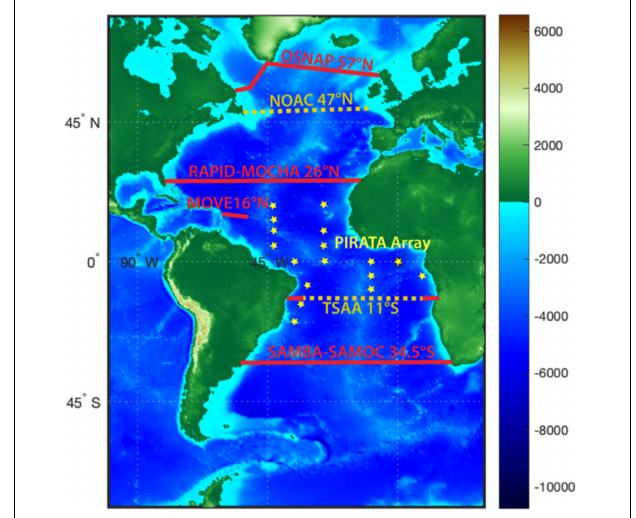
FIGURE 1 | Scheme of the moored observing arrays in the Atlantic with AMOC transports estimates from OSNAP 57 ◦ N, NOAC 47 ◦ N, RAPID 26 ◦ N, MOVE 16 ◦ N, TSAA 11 ◦ S, and SAMBA-SAMOC 34.5 ◦ S (see Frajka-Williams et al., 2019 for more details) and the Tropical Atlantic PIRATA mooring array (see Foltz et al., 2019 for more details). Argo and underwater glider arrays can be found in Roemmich et al. (2019) and Testor et al. (2019), respectively.